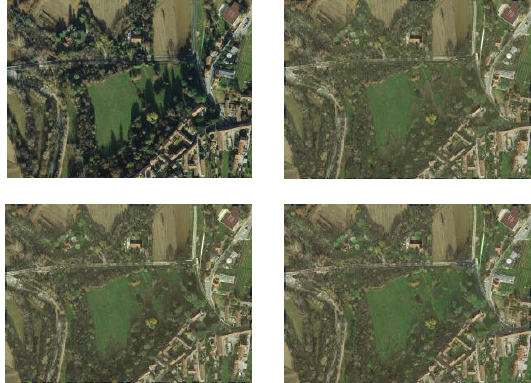
Figure 4: Original image and image after